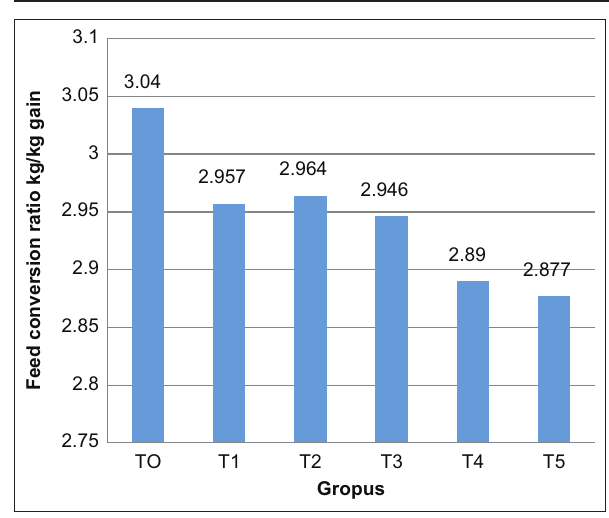
Figure-3: Efficacy of dietary supplementary probiotics on feed conversion ratio of male layer chicken during the starter period. Values are expressed in mean±standard error. One-way analysis of variance was carried out, followed by Duncan’s comparison test. a,b,c Different superscripts indicate significant differences